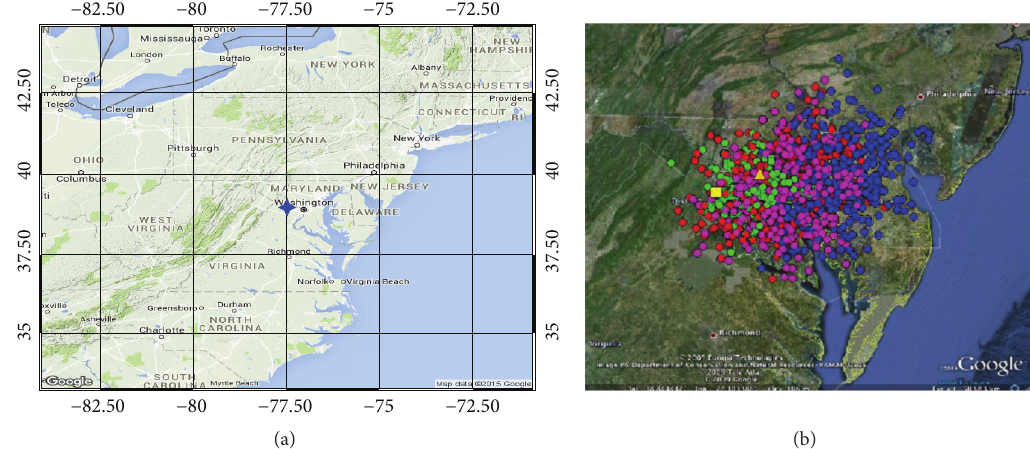
Figure2:(a)ReanalysisandCMIP5interpolatedto2.5 ∘ by2.5 ∘ gridcellstocomparewiththeradiosondestationsdata(bluestarrepresentsthe Sterling, VA, National Weather Station location). (b) Radiosonde burst location at 50hPa for the Sterling station. The circles in (b) represent JJA, SON, DJF, and MAM for green, red, blue, and purple, respectively, while yellow square and triangle represent Sterling radiosonde stations and Beltsville research site,